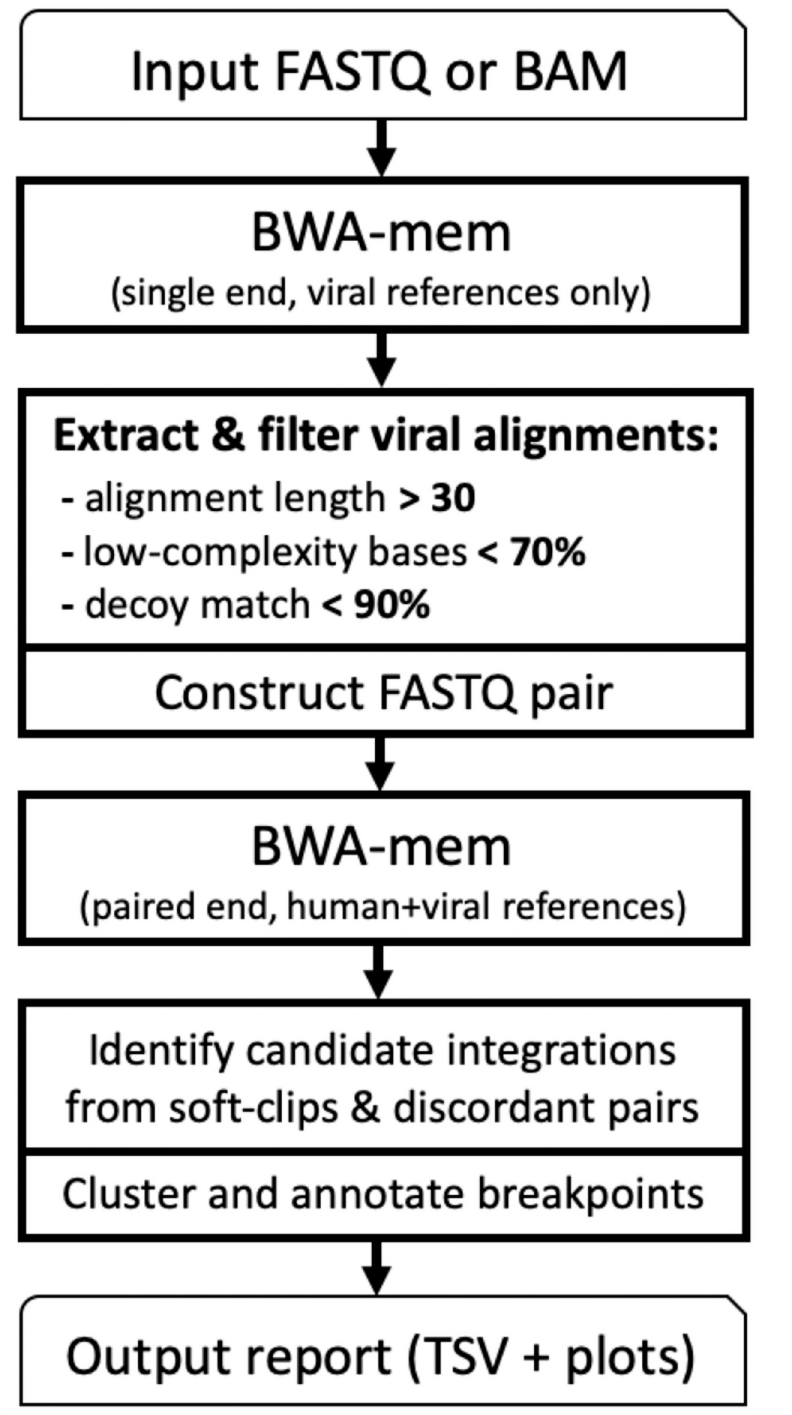
Fig 1. Overview of Exogene